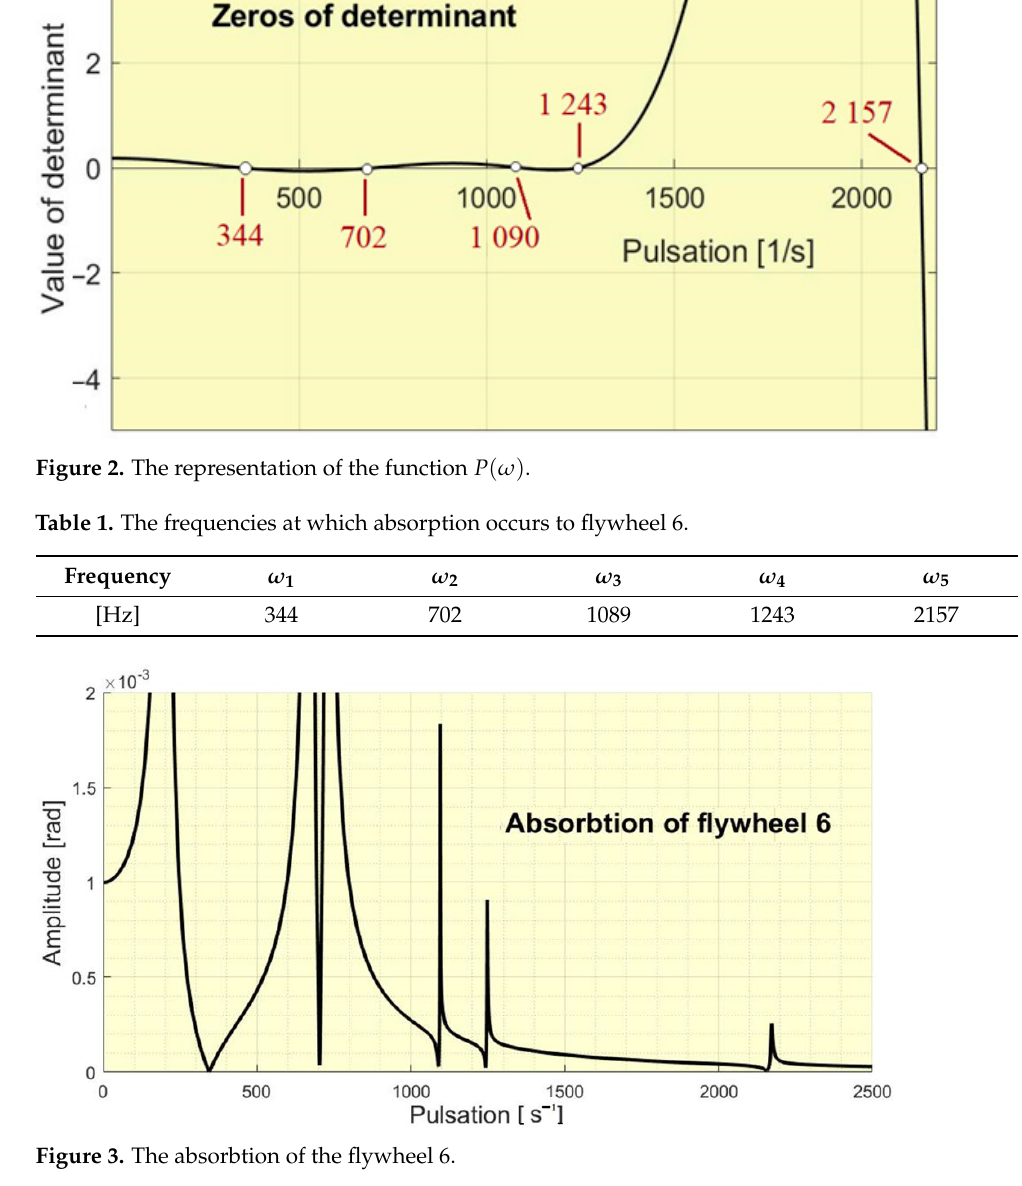
Figure 3. The absorbtion of the flywheel 6.